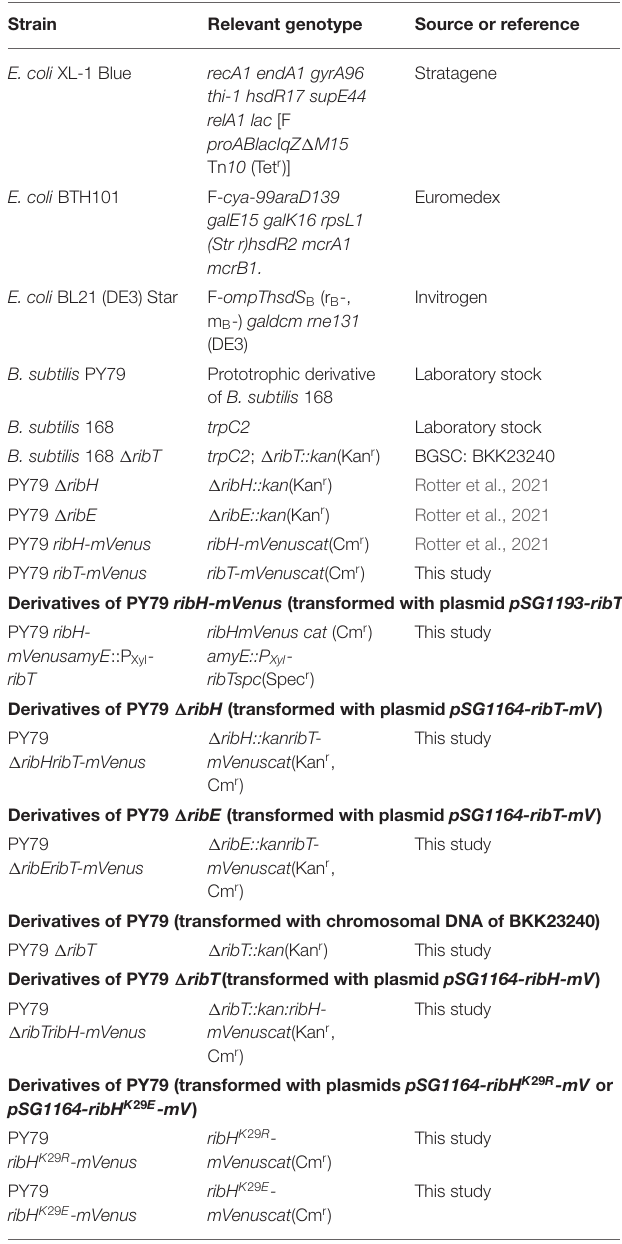
TABLE 2 | Strains used in this